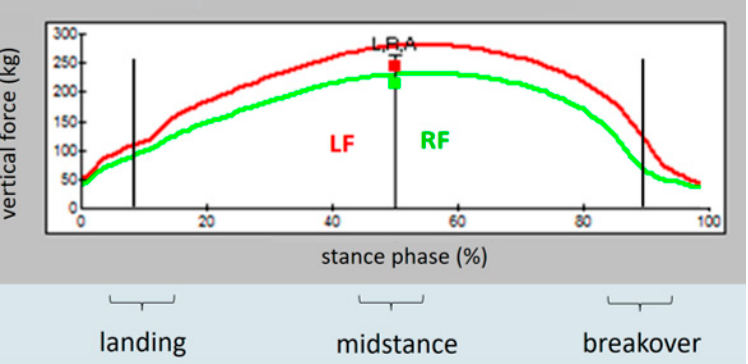
Figure 5. Averaged pressure–time curve of one horse in the current study with right forelimb lameness: vertical force in kg on the left (red) and the lame right (green) forelimb during landing (10% of the stance phase), midstance (50% of the stance phase), and breakover (90% of the stance phase) before anaesthesia.